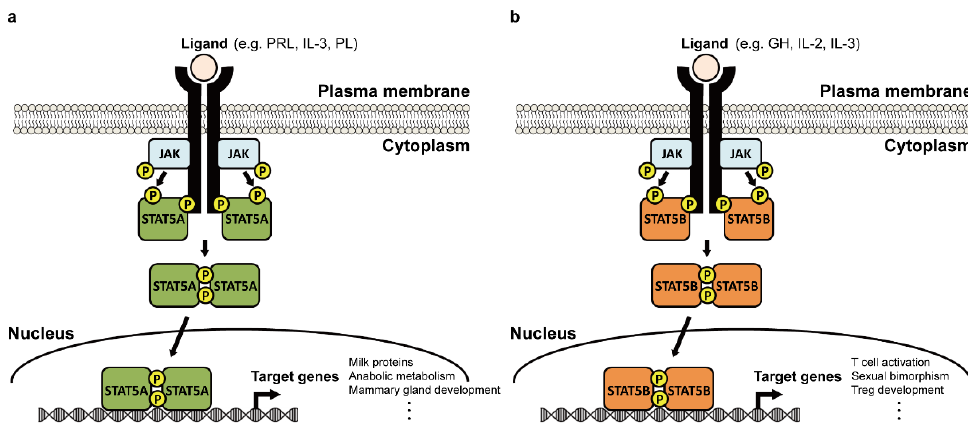
Figure 2. STAT5 activation mechanism. ( a ) STAT5A is activated by Janus kinases (JAK) in response to prolactin (PRL), interleukin-3 (IL-3), and placental lactogen (PL) to induce the expression of genes involved in mammary gland development and immune responses. ( b ) STAT5B is activated by JAK in response to growth hormone (GH), IL-2, and IL-3 and induces genes involved in body growth and immune responses.